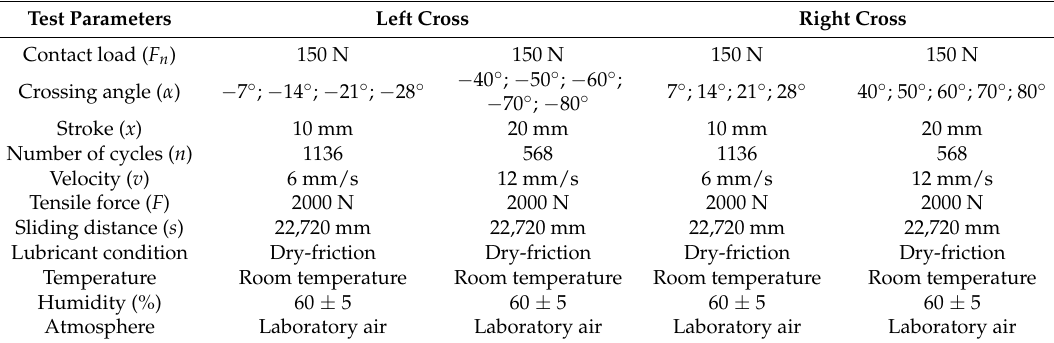
Table 2. Sliding friction test conditions for the cross contact ropes.